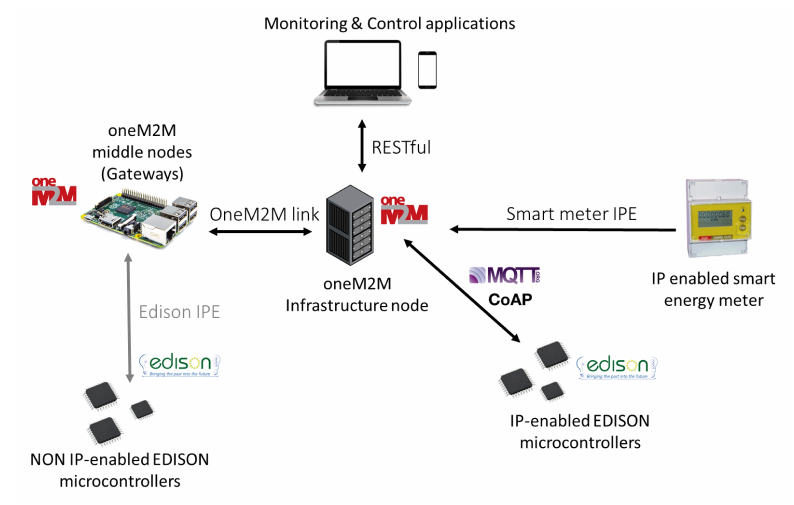
Figure 12. The complete EDISON solution with OneM2M.